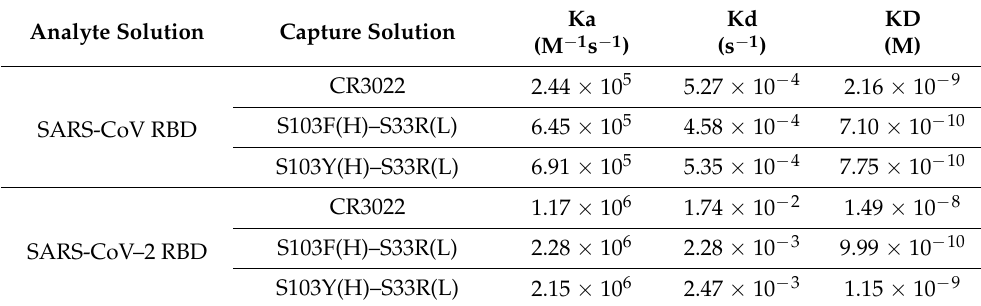
Table 2. The binding affinity (KD), association rate (ka) and dissociation rate (kd) value of CR3022 and its double-site mutation antibodies to SARS-CoV RBD and SARS-CoV-2 RBD. Analyte Solution Capture